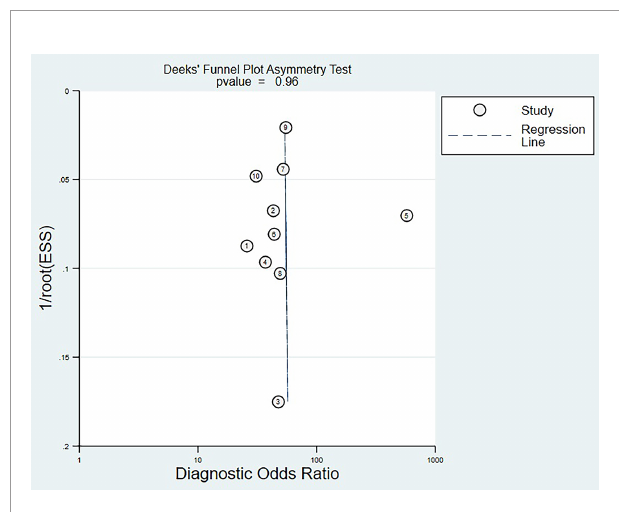
FIGURE 5 | Deek's funnel plot